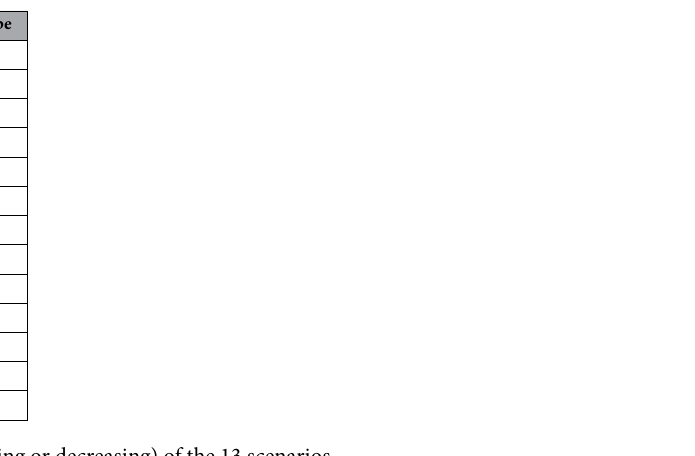
Table 8. Ranks and types (increasing or decreasing) of the 13 scenarios.